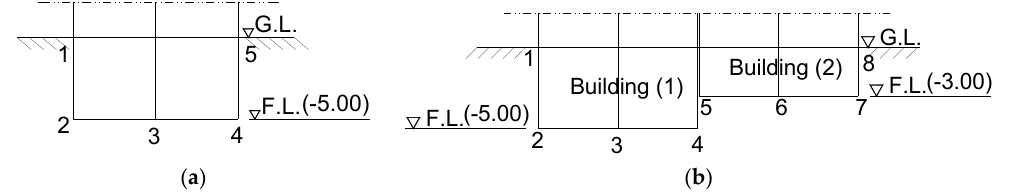
Figure 14. Points distributed around the foundations of the single building and the two adjacent buildings with unequal foundation levels. ( a ) Single building basement foundation; ( b ) The foundations with unequal levels of the two adjacent buildings.